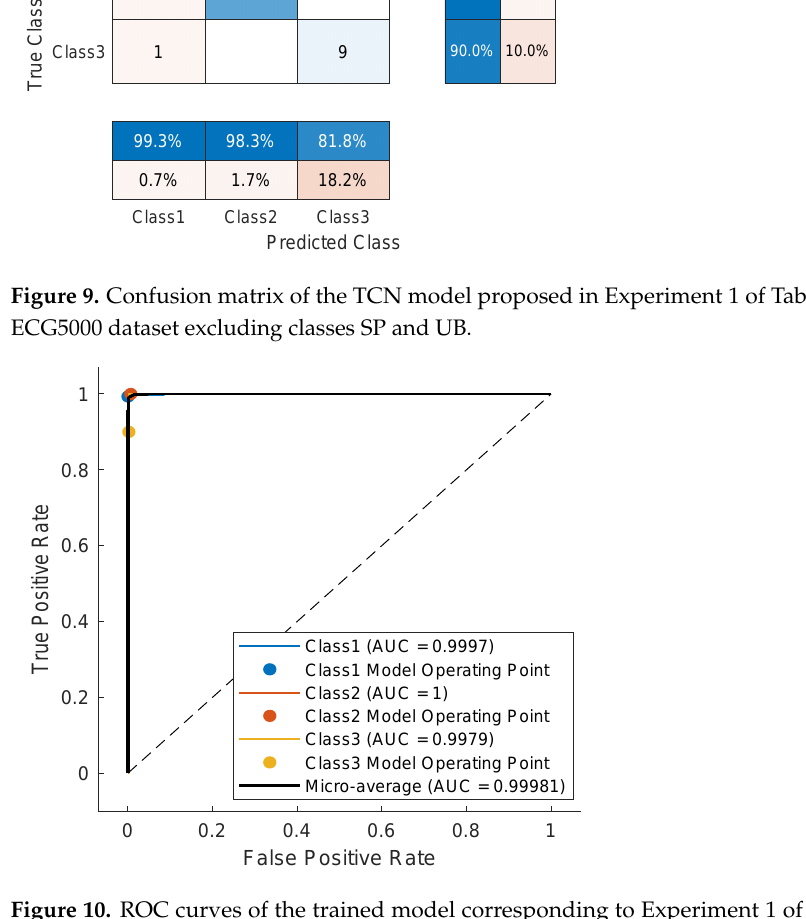
Figure 10. ROC curves of the trained model corresponding to Experiment 1 of Table 1, where the network is trained only on the first three classes. Table 4. Evaluation of different methods on the ECG5000